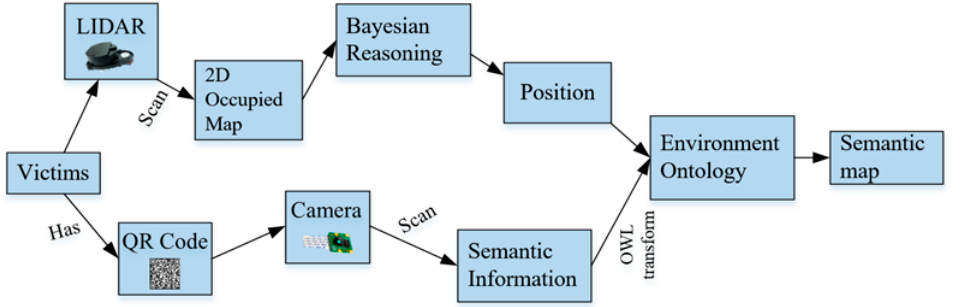
Figure 11. The process of semantic information recognition and updating.